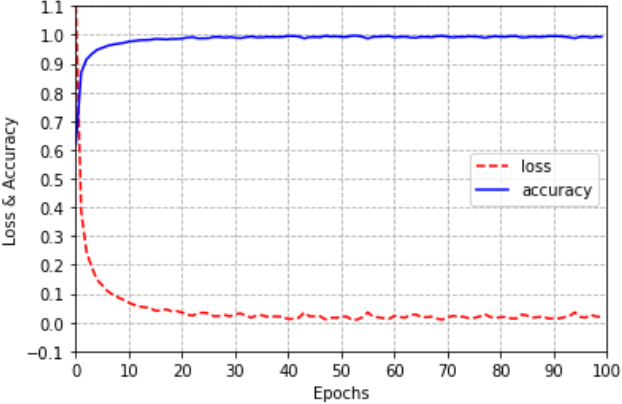
Figure 9. Training results for the proposed CRNN model.